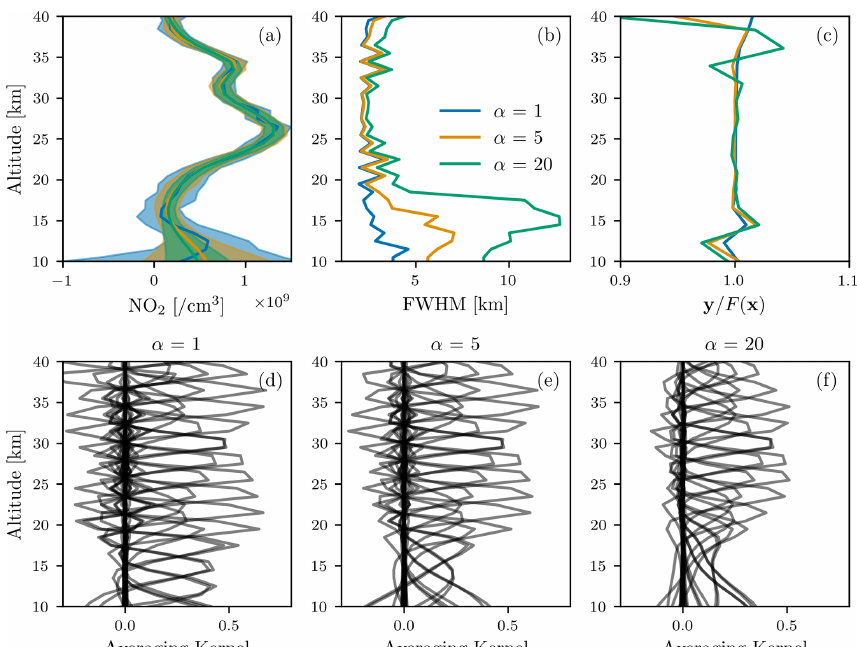
Figure 1. Retrieved NO 2 and diagnostic information for three different regularization scale values for OSIRIS scan 32921024 (8 March 2007, 23.9 ◦ N). (a) The retrieved NO 2 profile (solid lines) and 1 σ error estimates (shaded areas) for three regularization values. (b) The estimated vertical resolution of the retrieval for three regularization values. (c) The ratio of the OSIRIS measurement vector to the simulated measure- ment vector for three regularization values. (d–f) The averaging kernels for the three regularization values.